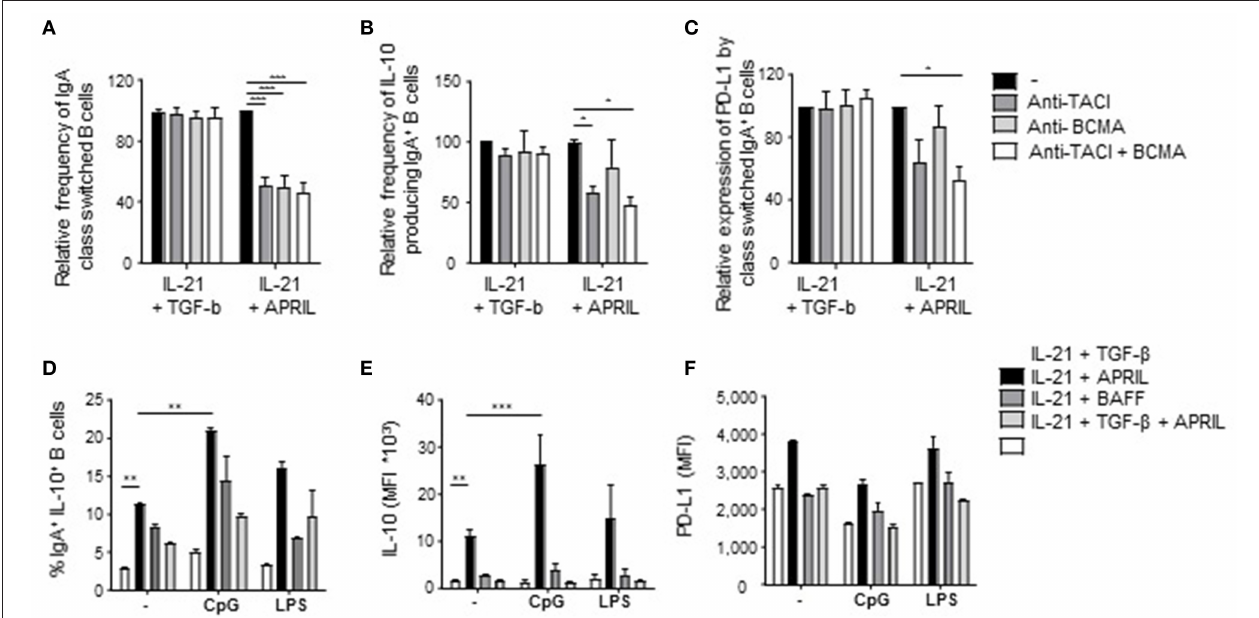
FIGURE 5 | Signaling via TACI is required for the induction of APRIL-driven regulatory IgA + B cells. Peripheral blood-derived naïve (CD19 + IgD + CD27 − ) B cells were cultured for 6 days in the presence of CD40L-expressing fibroblasts and IL-21 + TGF- β or APRIL. Blocking antibodies to TACI and/or BCMA were added to the cultures. After 6 days, class switching to IgA was analyzed using flow cytometry. (A) Relative frequencies of class switched IgA + in the presence of blocking antibodies to TACI and/or BCMA are shown. Mean ± SD are shown, n = 3. (B,C) The regulatory phenotype of the class switched IgA + B cells cultured in the presence of blocking antibodies to TACI and/or BCMA was assessed after 6 days of culture by analyzing the frequency of IL-10 + IgA + B cells (B) and the MFI of PD-L1 (C) using flow cytometry. (A–C) Data are normalized to the controls for each dataset (IL-21 + TGF- β s.. IL-21 + APRIL) separately. Mean ± SD are shown, n = 3. * P < 0.05 and *** P < 0.001 (one-way ANOVA with Bonferroni multiple comparison test). (D–F) The intrinsic regulatory phenotype of APRIL-induced IgA + B cells is enhanced in the presence of CpG. The frequency of class switched IgA + B cells (D) and the expression of IL-10 (E) and PD-L1 (F) were assessed using flow cytometry. Mean ± SD are shown, n = 3. ** P < 0.01 and *** P < 0.001 (two-way ANOVA with Bonferroni multiple comparison